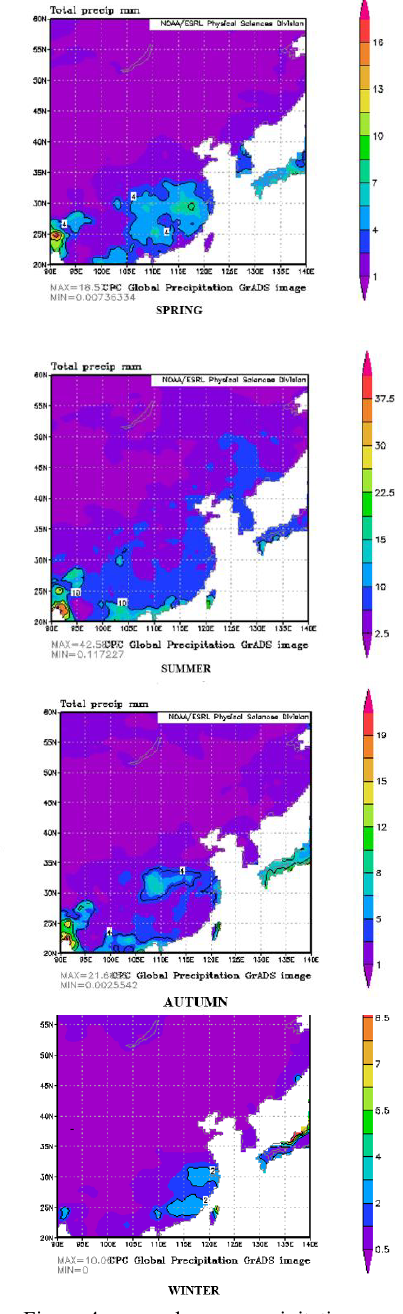
Figure 4 seasonal mean precipitation (cid:28595)(cid:28595)